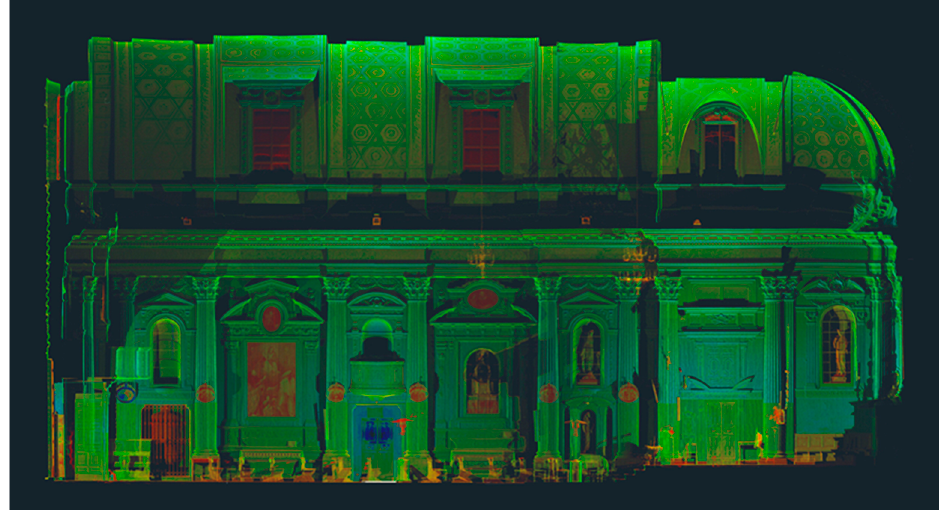
Figure 7. Results of Laser Scanner survey of the interiors of the Church. The high detail level, inside and outside, allowed the reconstruction of 3D printed model. (Survey carried out by by Malatesta M.B., Montefiori N., Natoli N., Pierantozzi G., Troli S. with Laser Scanner Leica HDS